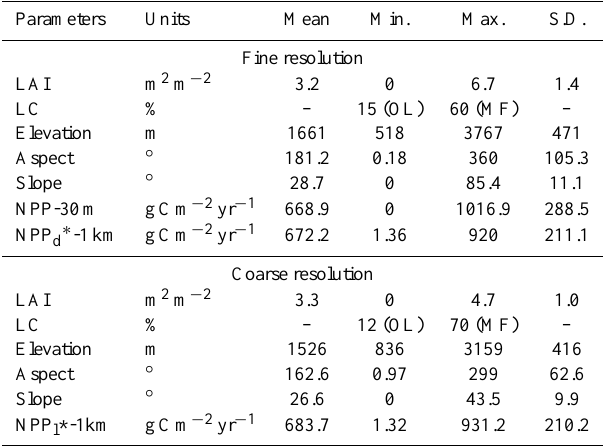
Table 1. Comparison of inputs and NPP results at 30m and 1km resolutions (CF: coniferous forest; MF: Mixed forest; OL: open